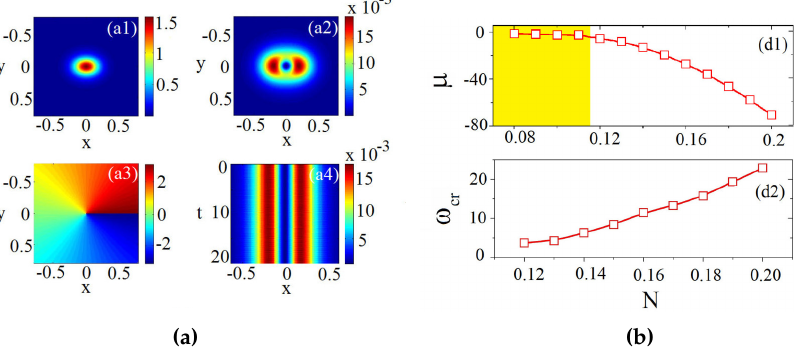
Figure 1. Stable symmetric vortex solitons (SVS) numerically obtained from Equation (4). ( a ) Stable SVS with total norm N = 0.15. (a1,a2) present the density distribution of the fundamental and vortical component, | φ + ( x , y ) | 2 and | φ − ( x , y ) | 2 , respectively. (a3) is the phase structure of the vortical component. (a4) is the direct run of this SVS. ( b ) The chemical potential µ versus N . The yellow area indicates where the SVS is subjected to oscillatory instability and transforms into breather mode